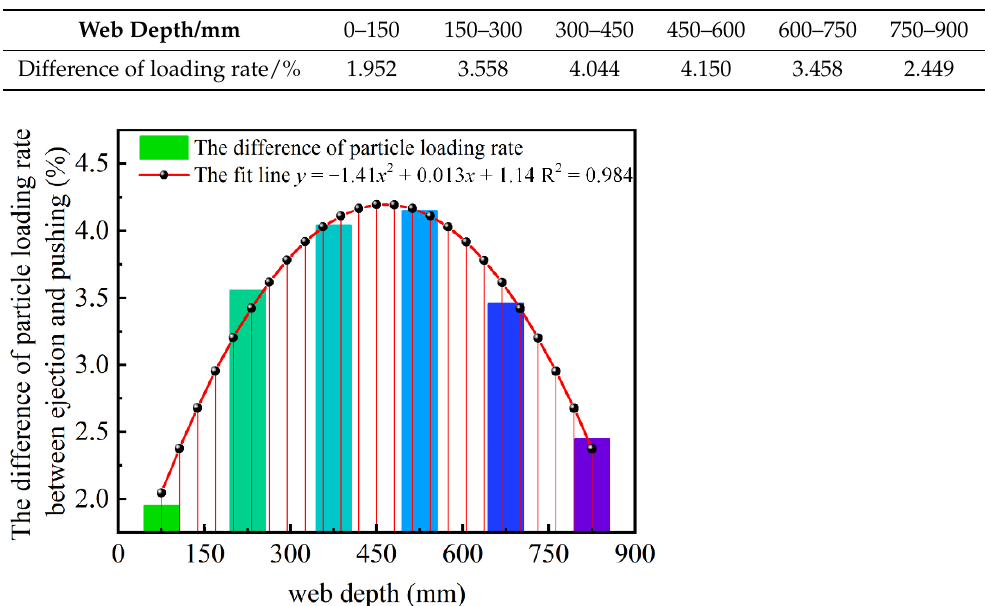
Figure 23. Loading rate of particles with different web depths. Table 2. The statistical results of differences in loading rate for particles with different web depths under ejection and pushing conditions.